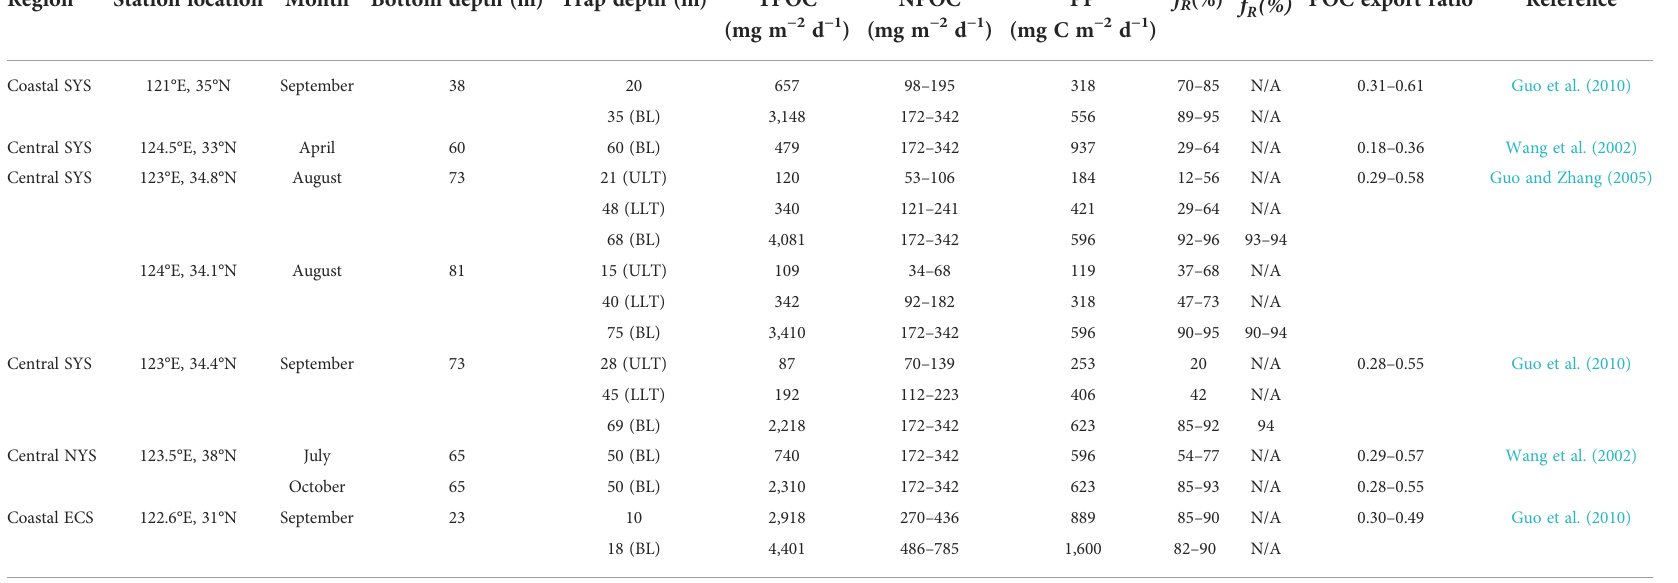
N/A, no data were reported in the corresponding reference. The PP data refer to the studies of Hama et al. (1997) and Wen et al. (2012). The f 0 R is the resuspension ratio of the bottom layer calculated by resuspension models in the corresponding references of Guo and Zhang (2005) and Guo et al. (2010). SYS, South YellowSea;ECS,EastChinaSea;NYS=NorthYellowSea;BL,bottomlayer;ULT,upperlayerofthethermocline;LLT,lowerlayerofthethermocline;TPOC,totalPOC fl uxbasedonsedimentstrapdata;NPOC,netPOC fl ux,i.e.,thedifferencebetweentotal settling and resuspension fl uxes; f R = (TPOC-NPOC)/TPOC; NPOC/PP, POC export